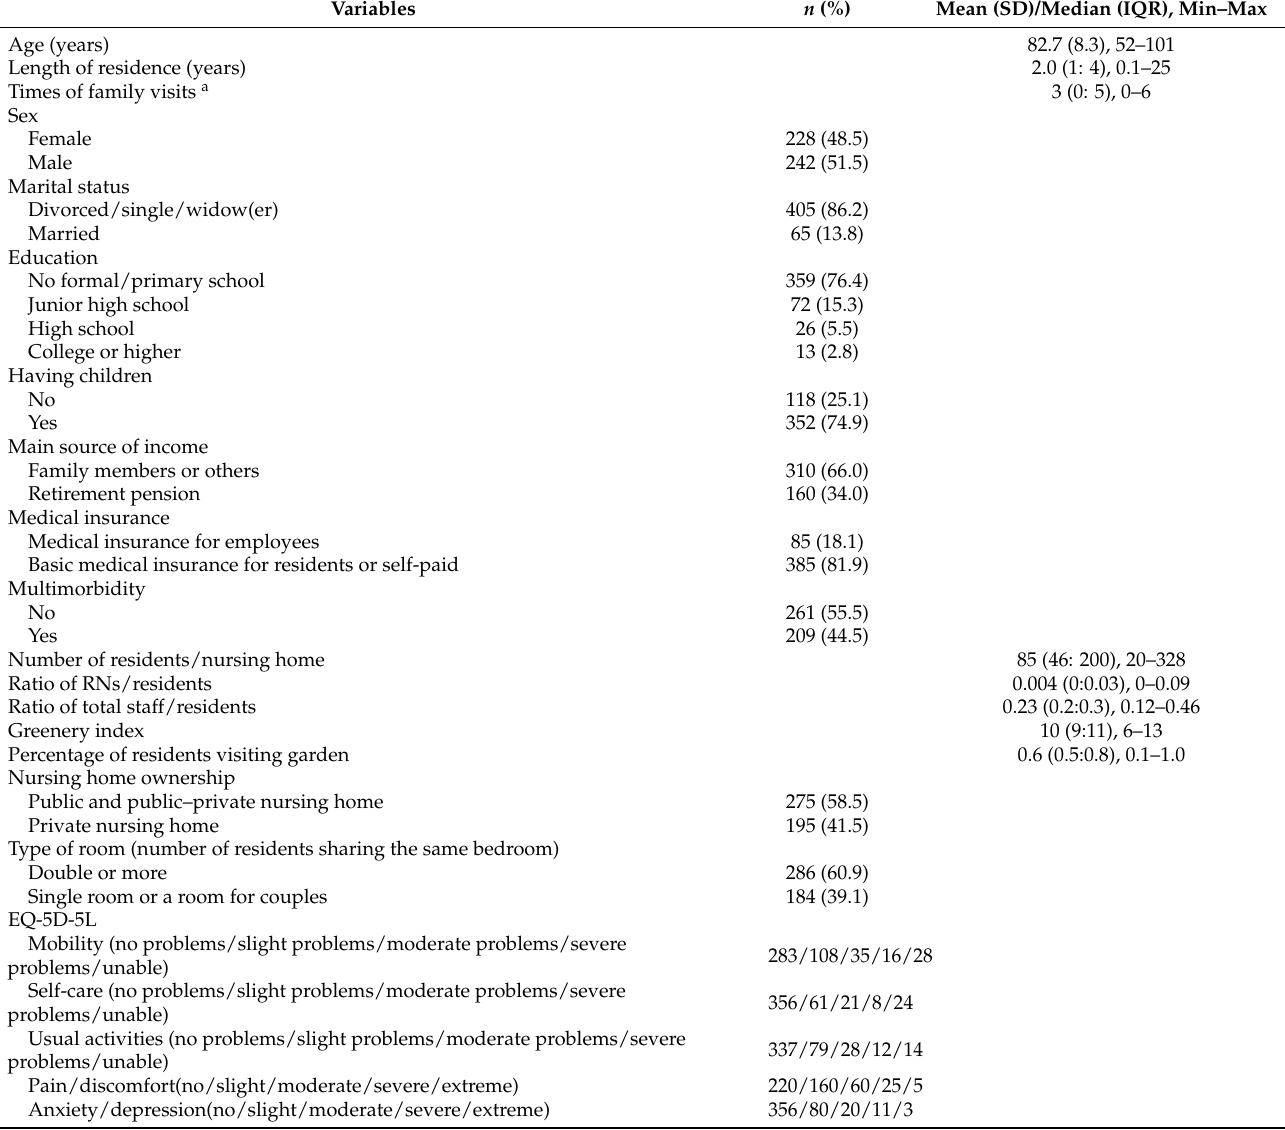
Table 1. Personal characteristics of residents and nursing home characteristics ( n = 470).